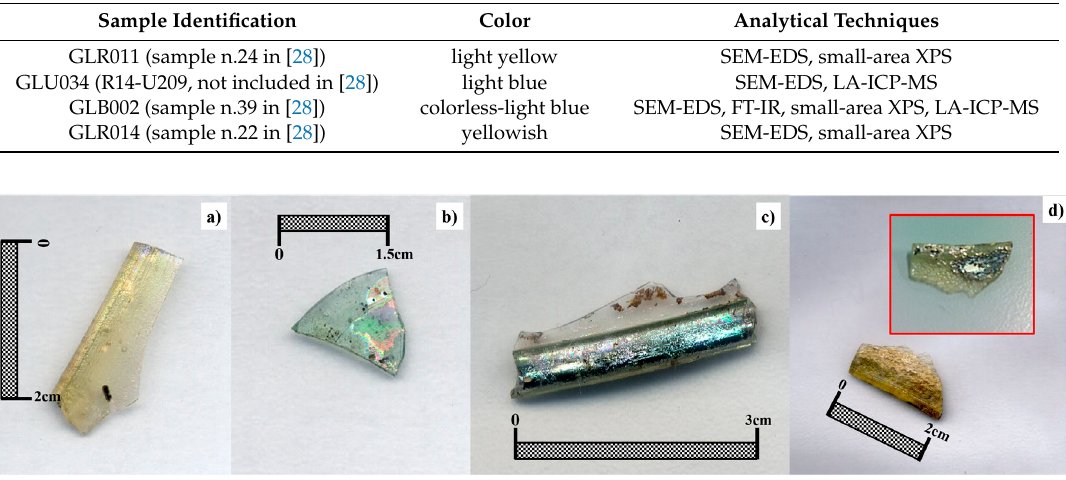
Figure 1. Samples GLR011 ( a ) and GLU034 ( b ) and GLB002 ( c ) and ( d ) GLR014 showing typical degradation layers. The names of the fragments are the first ones assigned after the excavation: they indicate the material glass GL, and the type of fragment referred to a shape (B base, R rim, U unidentified)